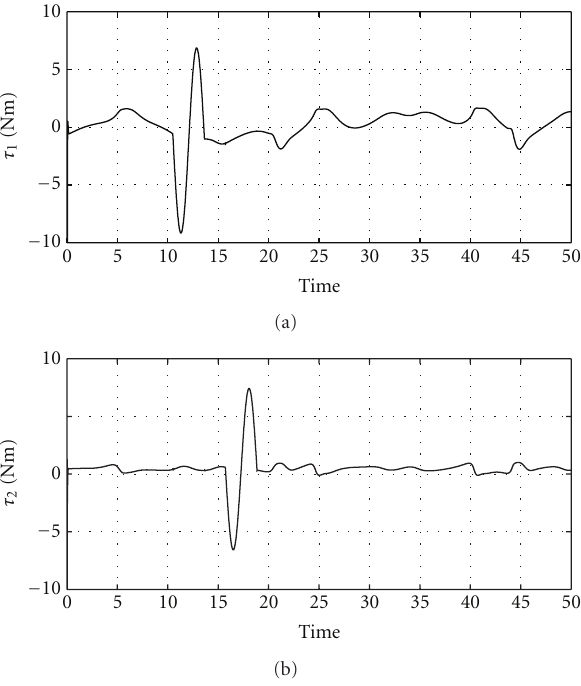
Figure 5: Control torques provided by the robust